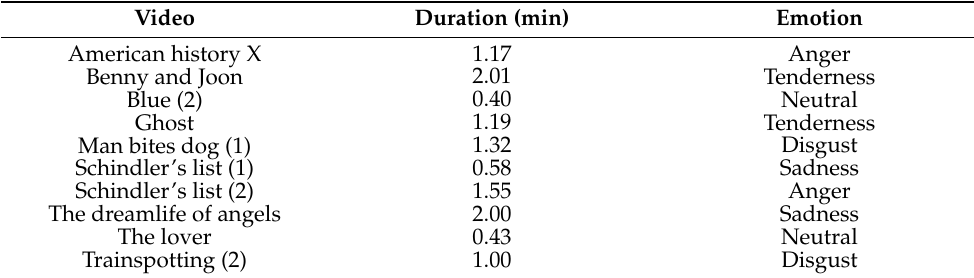
Figure 1. Valence and arousal space with the corresponding location of the emotional classes that were used in the study. Table 1. Emotion-evoking